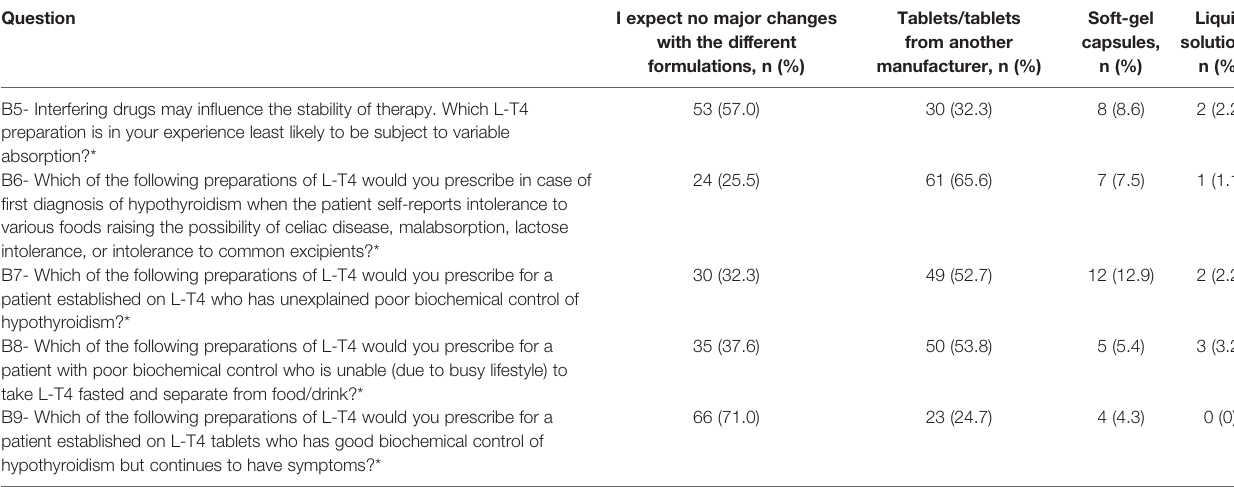
TABLE 2 | Use of different L-T4 formulations in various clinical situations. Question I expect no major changes